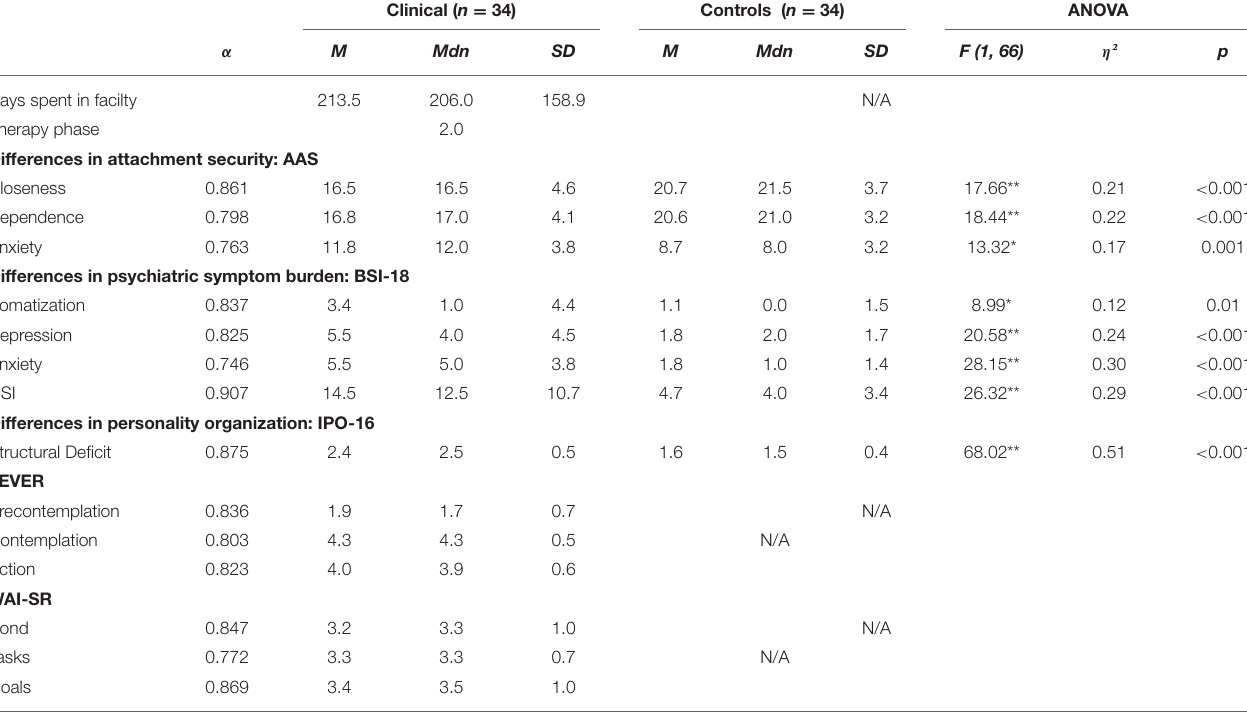
TABLE 2 | Group differences in behavioral